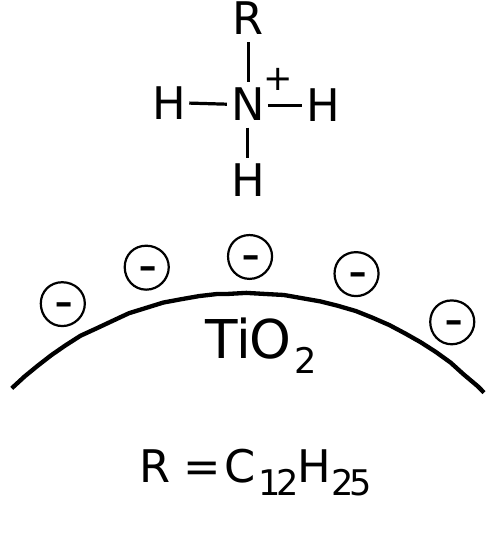
Figure 9. Schematic representation of bonding of DDAmine@TiO